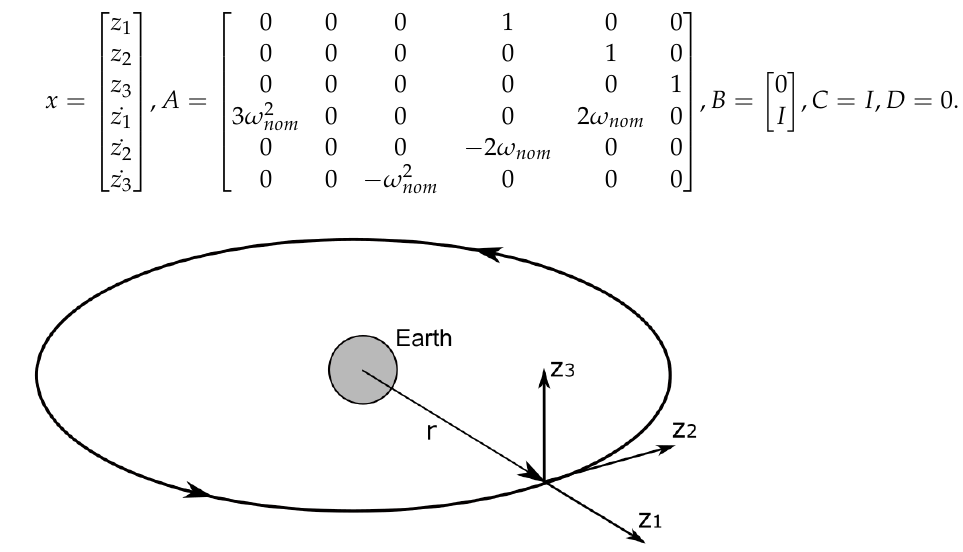
Figure 2. Hill–Clohessy–Wiltshire frame of